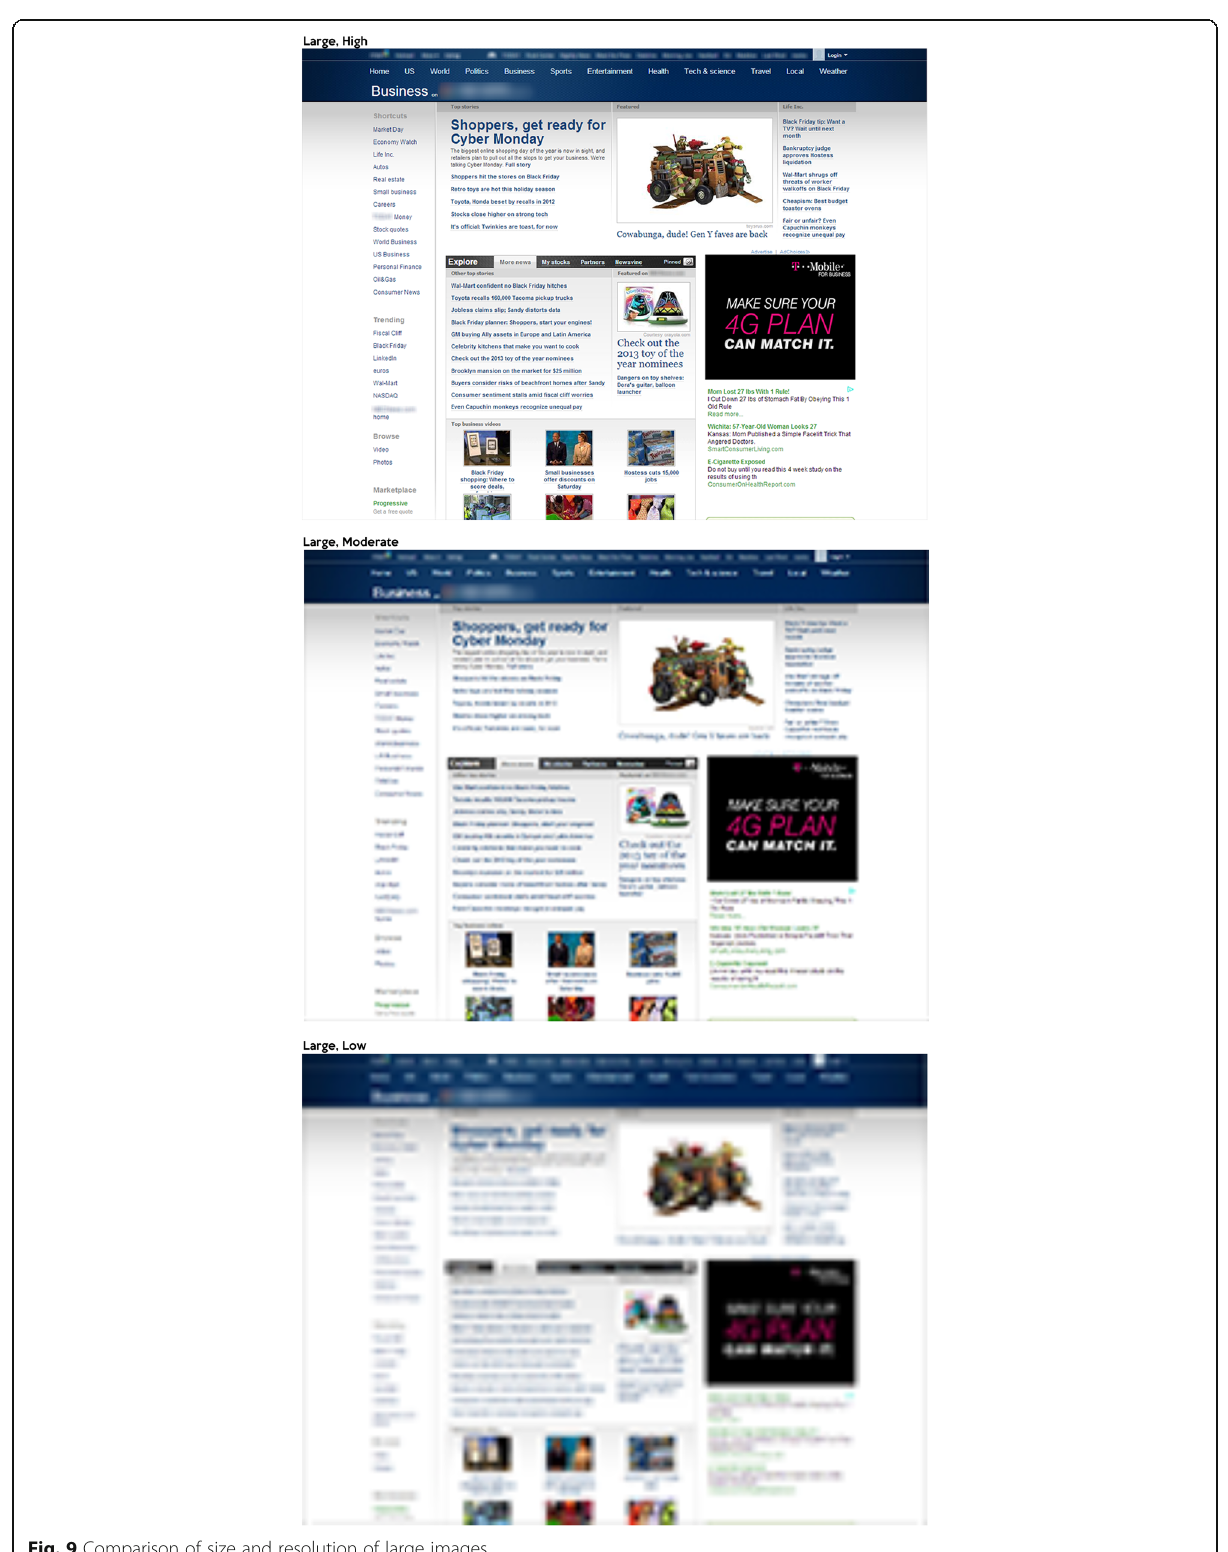
Fig. 9 Comparison of size and resolution of large